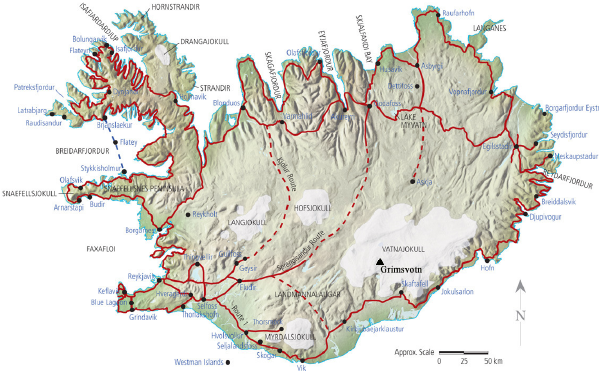
Figure 2. Map of Iceland showing towns, the road network, and the location of